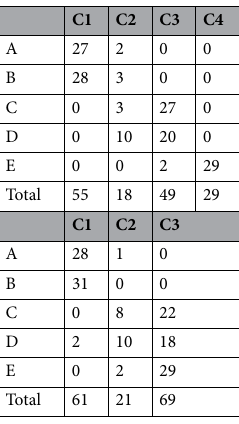
Table 3. Distribution of the communities by group in wave 1 (left) and wave 2